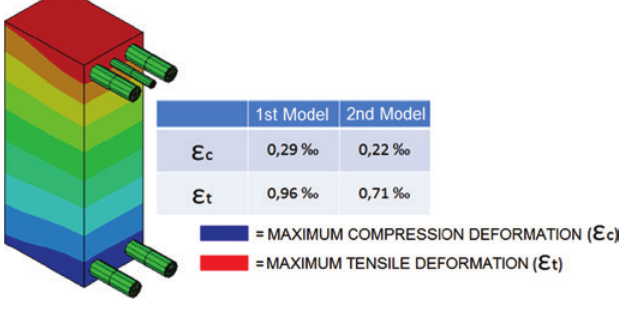
Figura 12 Deformações no concreto na seção de momento máximo